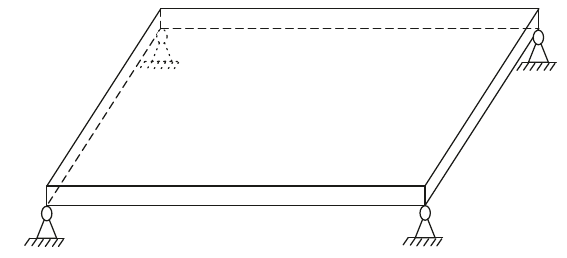
Figure 2: A multi-DOF vibration model of the